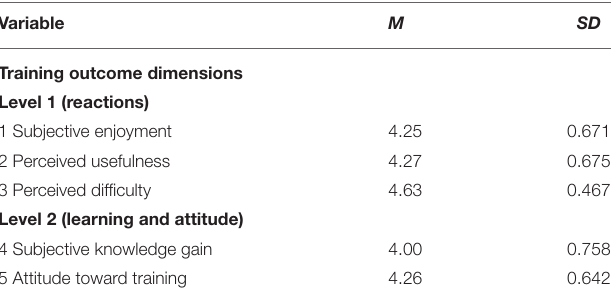
Frontiers in Public Health |